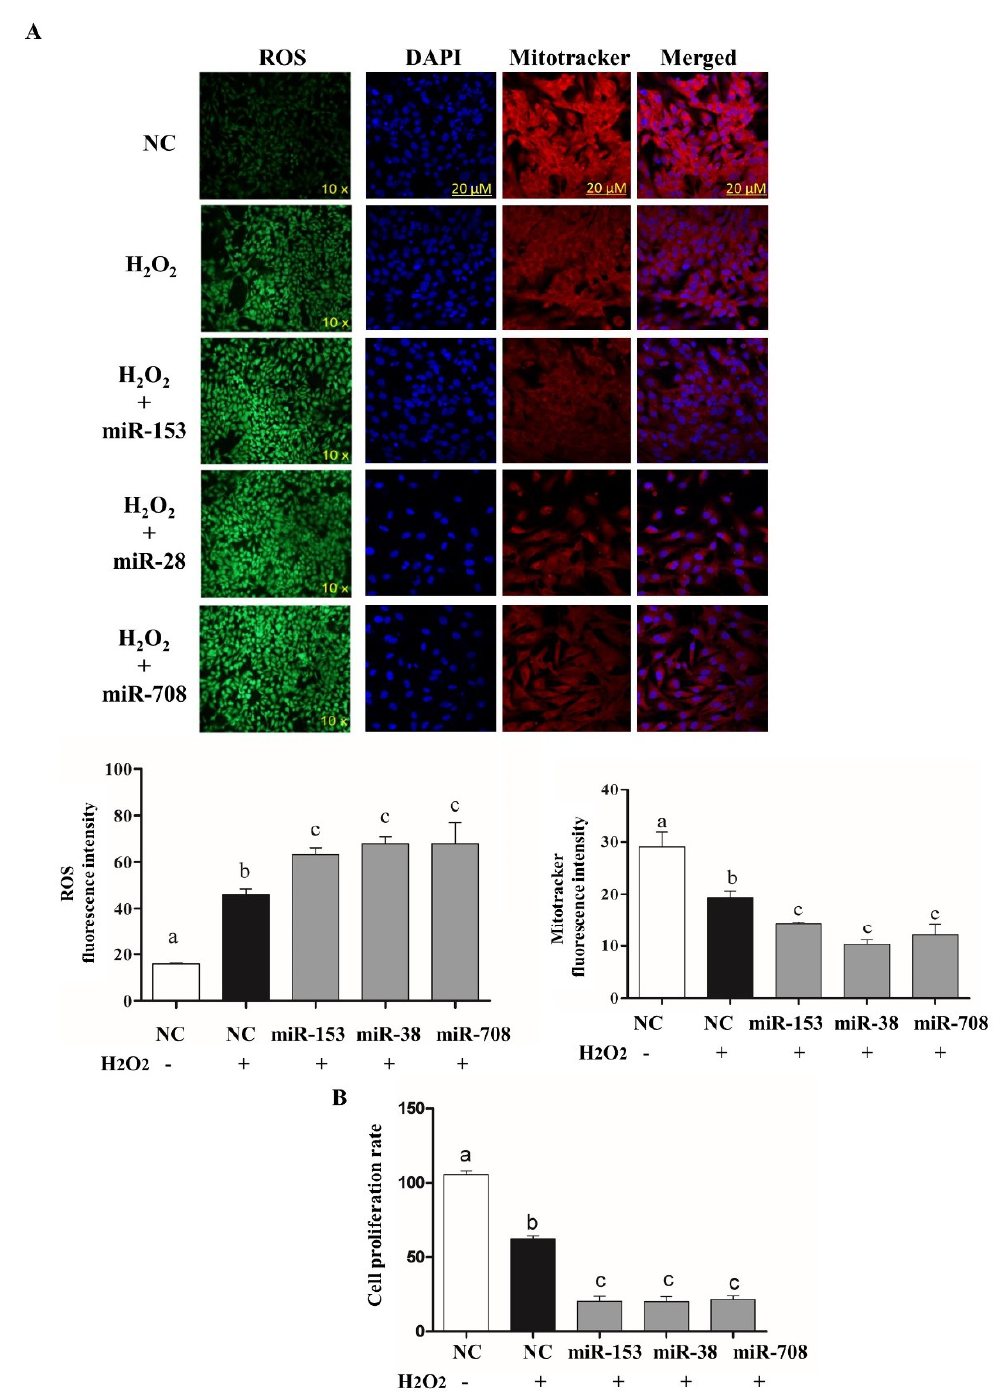
Figure 6. Overexpression of miR-153, miR-28 and miR-708 under oxidative stress conditions increased the intracellular ROS level and reduced the mitochondrial activity compared to cells treated with only H 2 O 2 ( A ). Moreover, bovine granulosa cell proliferation was significantly reduced in cells transfected with miRNA mimics under H 2 O 2 ( B ). White bars indicate the cells transfected with negative control without H 2 O 2 . Dark bars indicate cells transfected with negative control under H 2 O 2 and gray bars represent cells transfected with miRNA mimics under the H 2 O 2 challenge. Data are presented as mean ± SEM of three independent biological replicates. Bars with different letters (a,b,c) showed statistically significant differences ( p ˂ 0.05).